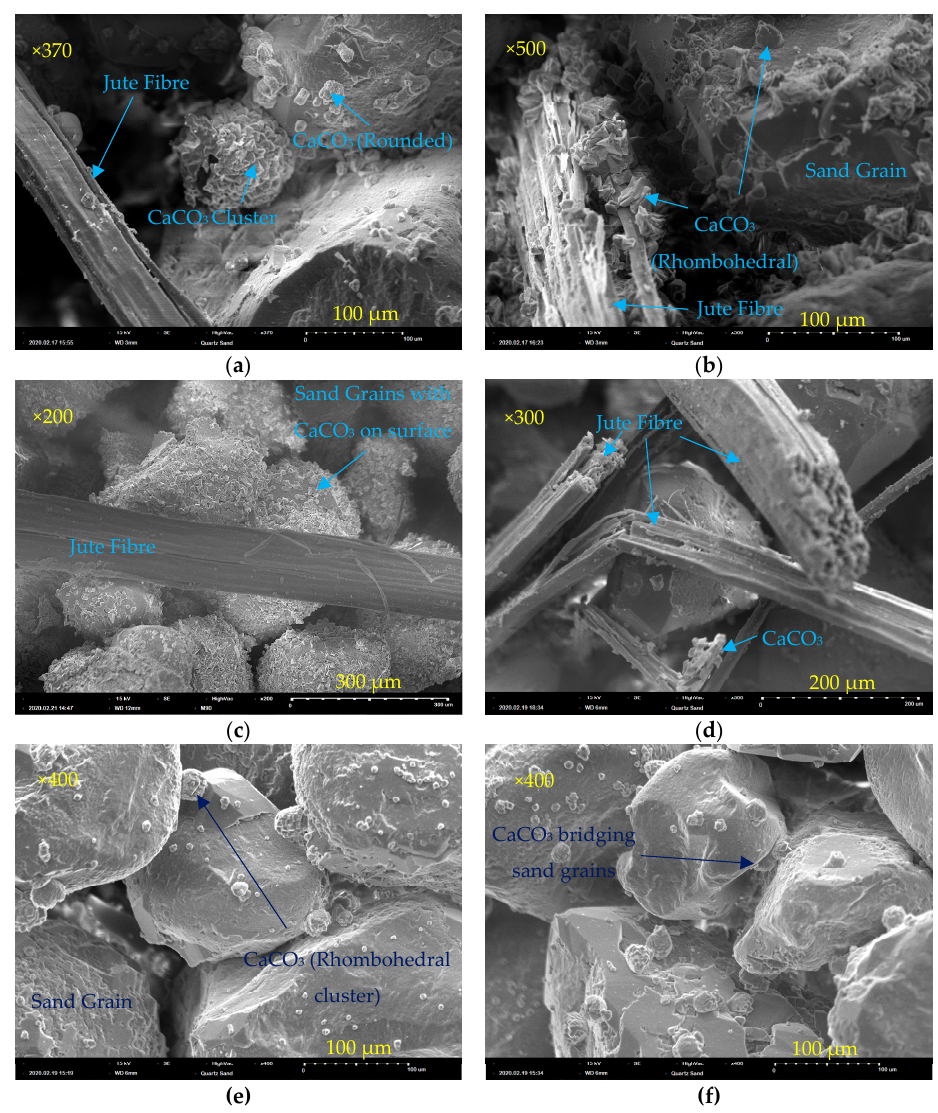
Figure 15. SEM images of samples from biocemented sand columns containing jute ( a , b ), treated jute ( c , d ), and sand only controls ( e , f ).